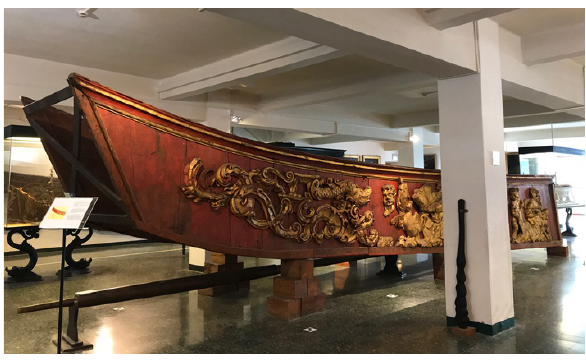
Figure 3. The cortelà, the two stern